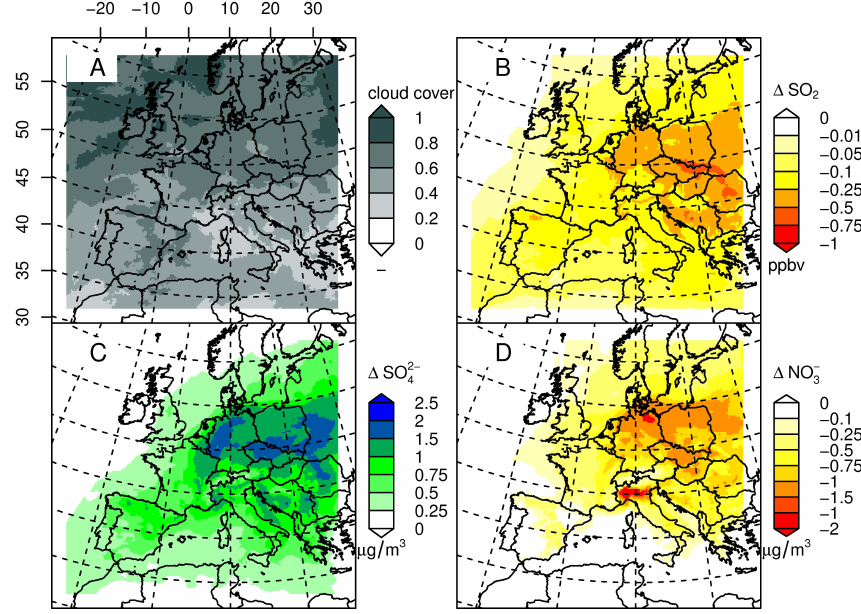
Fig. 5. Maps of mean total cloud cover (A) , absolute changes in gas-phase SO 2 (B) , and in SO 2 − inclusion of the new scavenging module. Shown are mean differences (plots B , C , D ) over the whole simulation